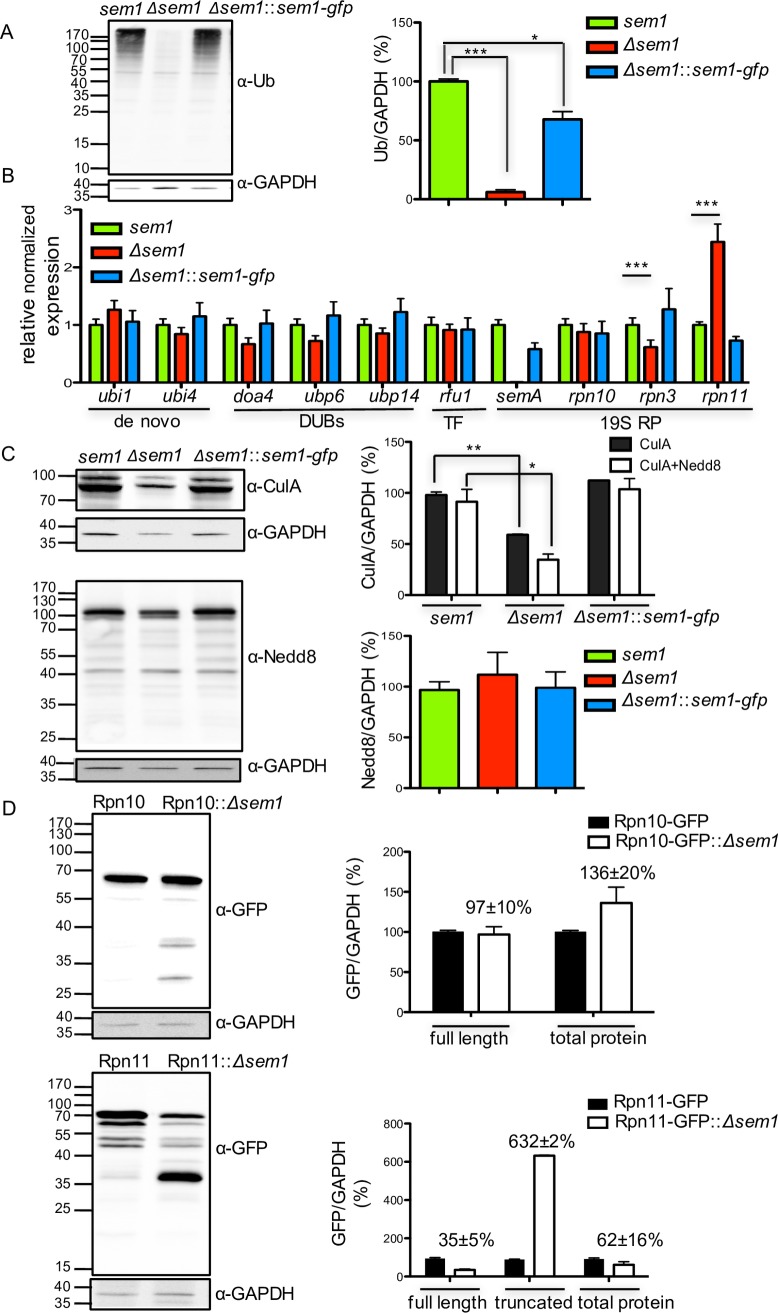
Deletion of sem1 promotes decrease in the total ubiquitin-conjugates and destabilization of the Rpn11 deubiquitinating enzyme.(A) Significant decrease in polyubiquitylated substrates upon deleting sem1. Polyubiqutinated substrates were detected with α-ubiquitin and α-GAPDH served as loading control. T-test of Δsem1 vs sem1, ***p<0.001 and sem1 vs Δsem1::sem1-gfp, *p<0.05, n = 2. (B) Transcription levels of 19S RP subunits and genes involved in maintaining intracellular ubiquitin pools. RT-PCR results are shown as relative expression compared to sem1, n = 4, ***p<0.001. (C) Reduced amount of CulA/Cul1 protein in Δsem1. Neddylated substrates were detected with α-CulA (n = 3) and α-Nedd8 (n = 2), respectively, *p<0.05, **p<0.01. (D) Stability of Rpn10-GFP and Rpn11-GFP proteins in Δsem1. Western blots were probed with α-GFP to determine the relative amounts of full-length and truncated (37KDa) proteins. Mean intensities from three biological replicates were normalized to GAPDH (see also S2 and S3 Figs).